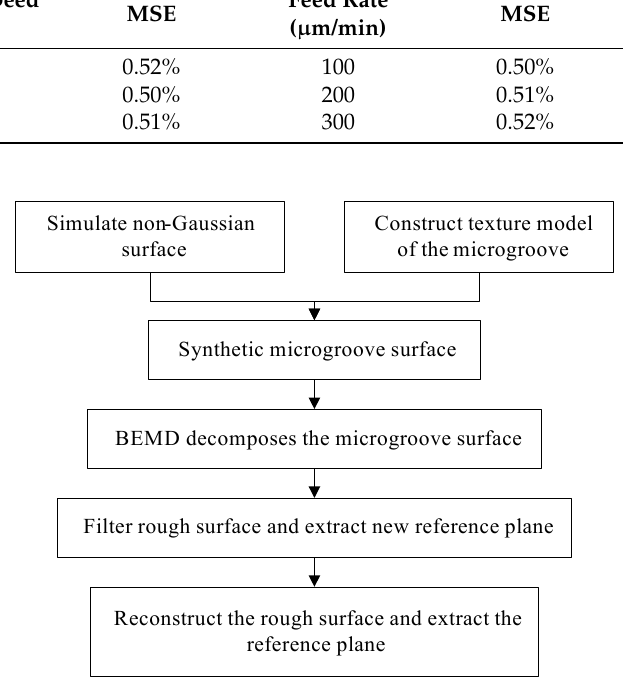
Figure 11. The extraction process of the reference plane.